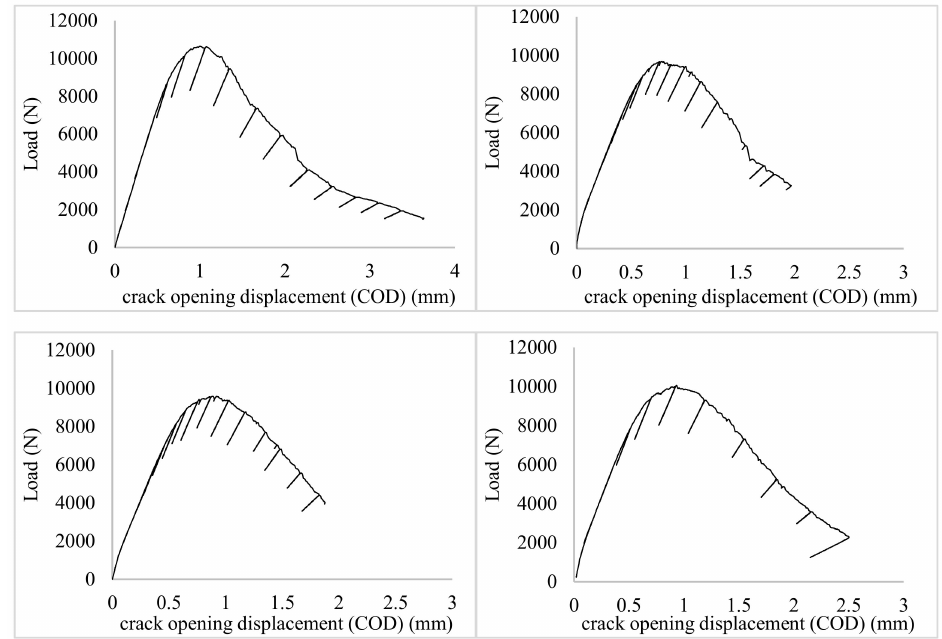
Figure 4. Force—crack opening displacement (COD) curve in compact tension specimens for AA2519 tested under ambient conditions.